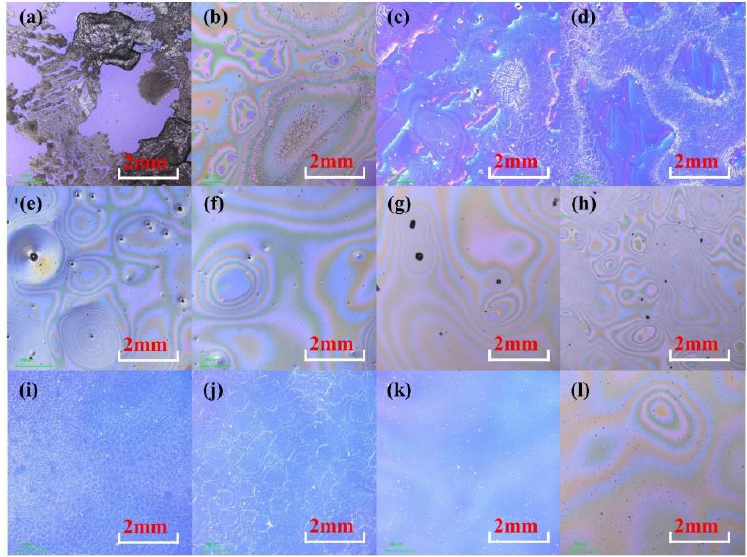
Figure 4. Screen printing films by different solutions: ( a ) AMT solution without polyvinyl alcohol (PVA) and FSO, ( b ) with 1.1 wt.% PVA, ( c ) with 2.0 wt.% PVA, ( d ) with 2.9 wt.% PVA, ( e ) with 3.8 wt.% PVA, ( f ) with 4.7 wt.% PVA, ( g ) with 5.6 wt.% PVA, ( h ) with 6.5 wt.% PVA, ( i )with 3.8 wt.% PVA + 0.013 wt.% FSO, ( j ) with 4.7 wt.% PVA + 0.016 wt.% FSO, ( k ) with 5.6 wt.% PVA + 0.019 wt.% FSO, ( l ) with 6.5 wt.% PVA + 0.022 wt.% FSO.